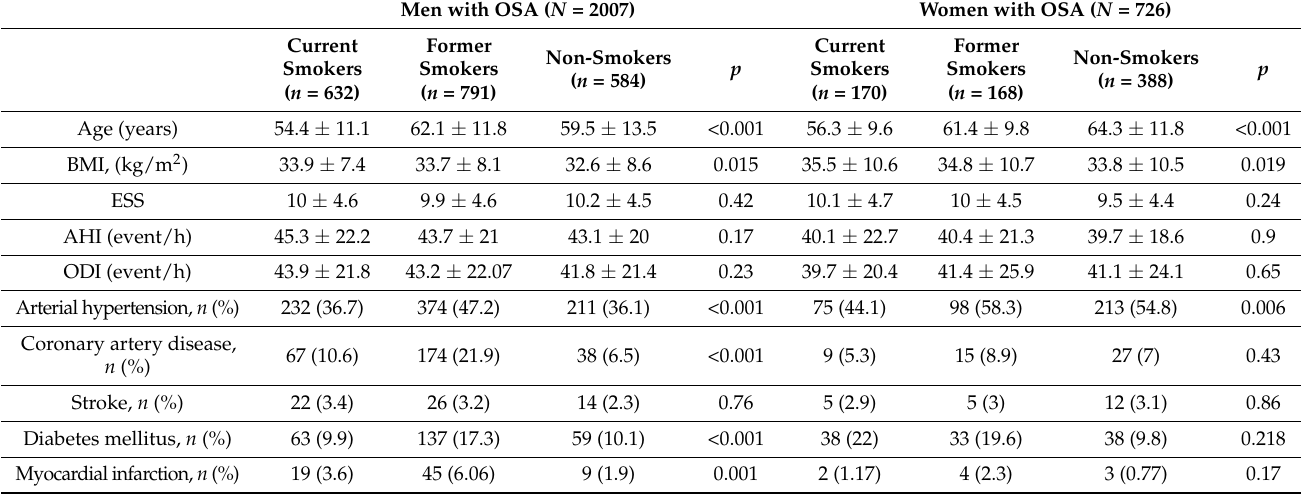
Table 5. Comparison of smokers, former smokers and non-smokers with OSA (AHI ≥ 15) according to